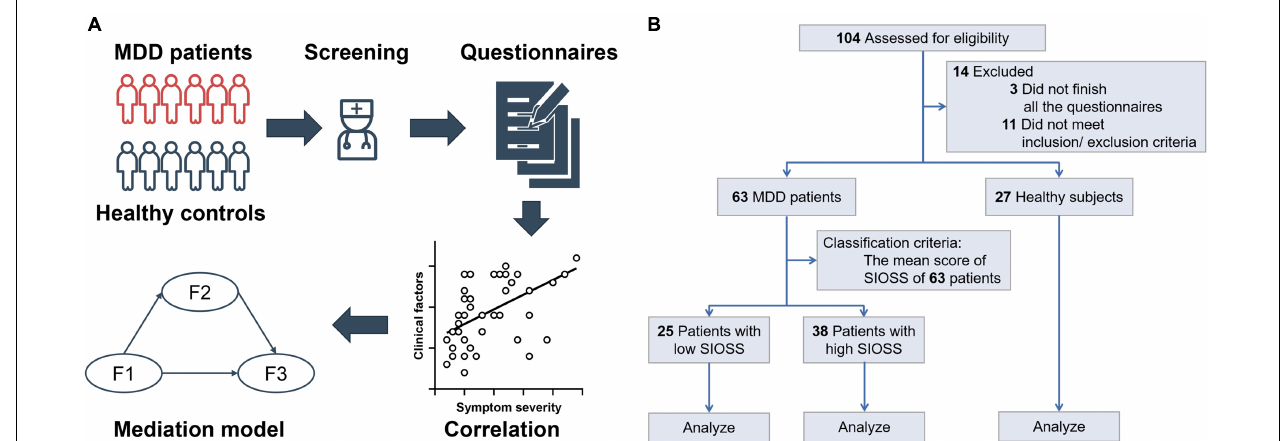
FIGURE 1 | The procedure of the study. (A) Study procedure; (B) The flow chart of sample